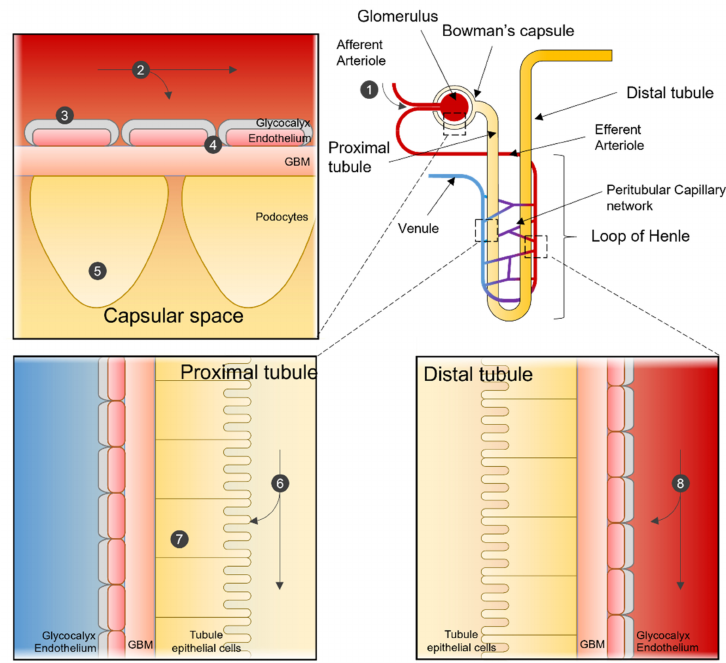
Figure 2. Nanoparticle interactions in the Nephron. Sites of interaction and potential uptake of NPs that are subject to extraction or used to target the kidney. NPs enter the kidney via the renal artery and are transported to the afferent arteriole (1). Depending on particle characteristics, NPs remain in the blood stream or are subjected to renal filtration from the blood in the glomerular capillaries (2). NPs can be designed so that renal structures, such as the glycocalyx (3), endothelial cells, or the glomerular basement membrane (4), can function in selecting NPs for filtration. After filtration, NPs can interact with podocytes in the Bowman’s lumen (5). NPs in the filtrate are then transported to the proximal tubule, where they interact with proximal epithelial cells (6) and are potentially reabsorbed. Pro-drug NPs can be activated in the lysosome of proximal tubular cells (7). NPs not selected for renal filtration can interact with the renal tubular comparted after being transported from the efferent arteriole to the peritubular network